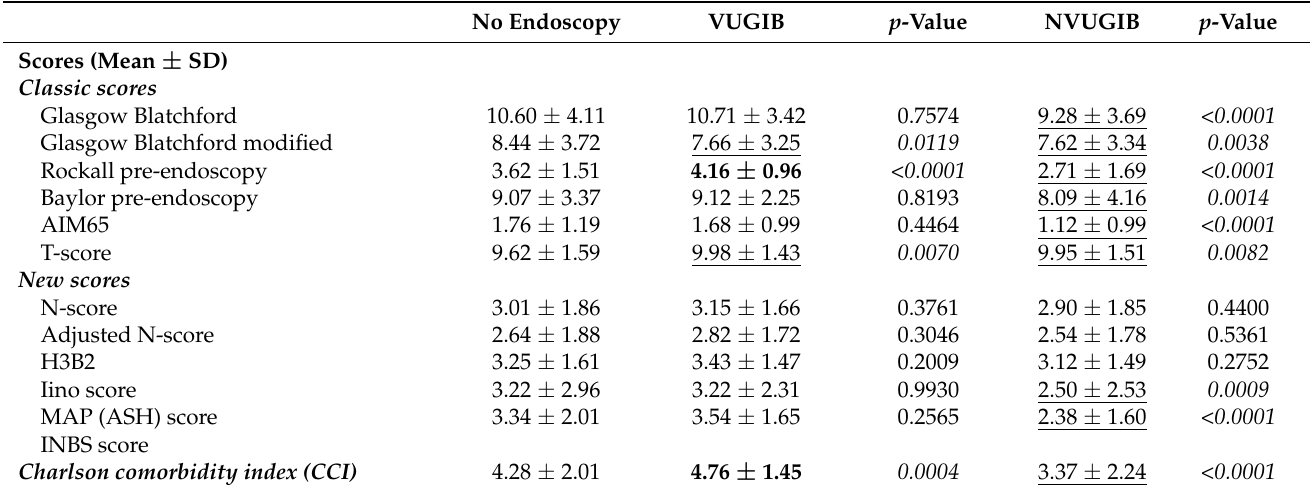
Table 12. Mean prognostic scores in patients with no endoscopy performed. No Endoscopy VUGIB p -Value